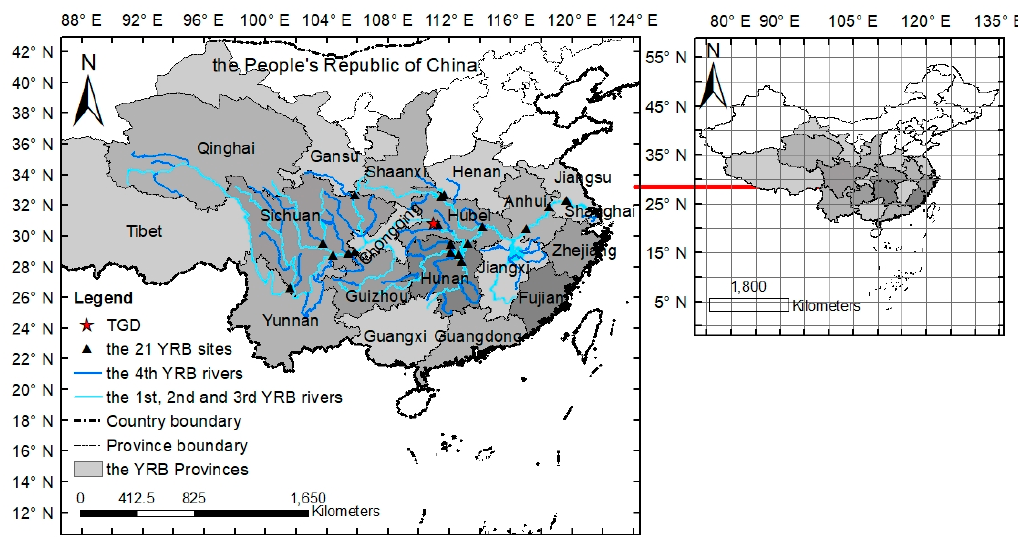
Figure 1. Maps of the 21 sites and area of the Yangtze River Basin (YRB) under the national monitoring program.